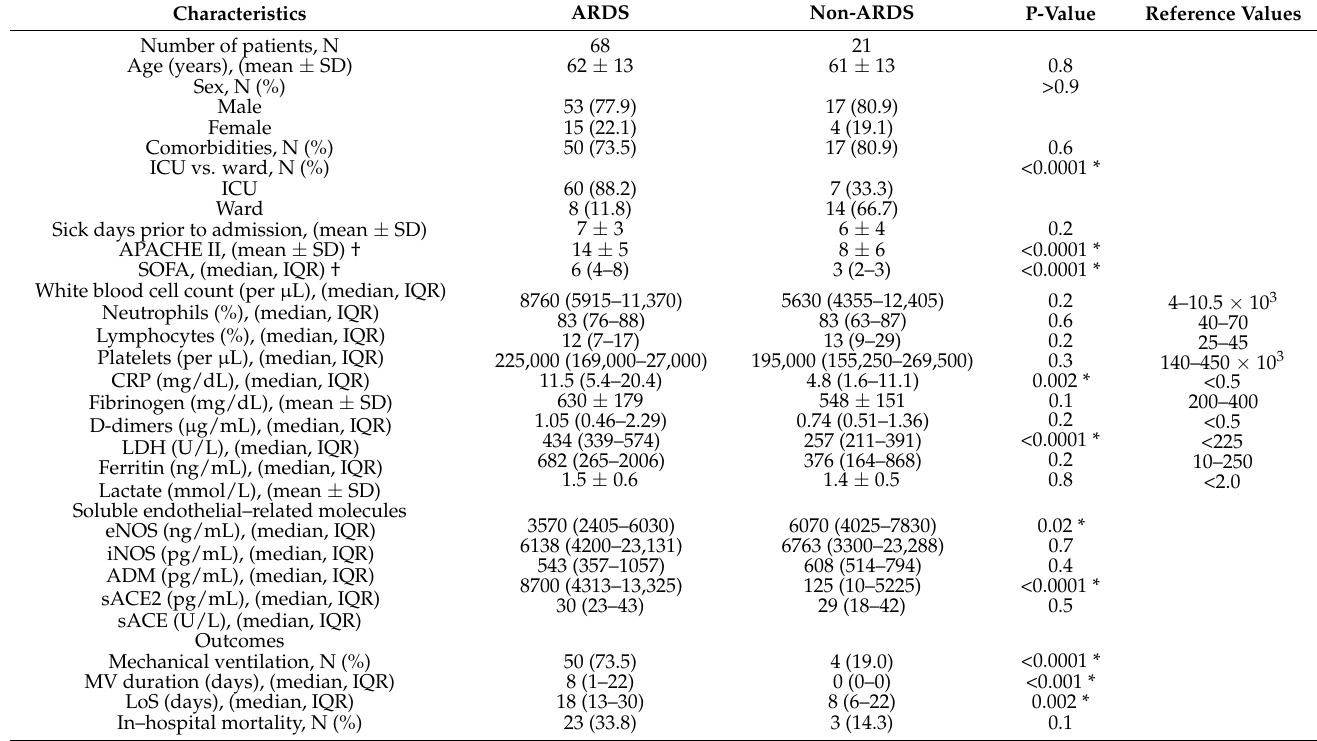
Table 1. Demographics, clinical characteristics, and endothelium-related protective molecules of hospitalized COVID-19 patients upon admission (within 24